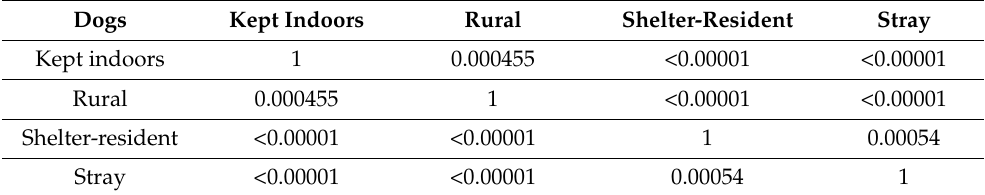
Table 2. The p -values for the chi-squared analysis comparing the prevalence of Blastocystis in dogs kept under different conditions, calculated on the basis of the data from Tables 1 and S1. Dogs Kept Indoors Rural Shelter-Resident Stray Kept indoors 1 0.000455 <0.00001 <0.00001 Rural 0.000455 1 <0.00001 <0.00001 Shelter-resident <0.00001 <0.00001 1 0.00054